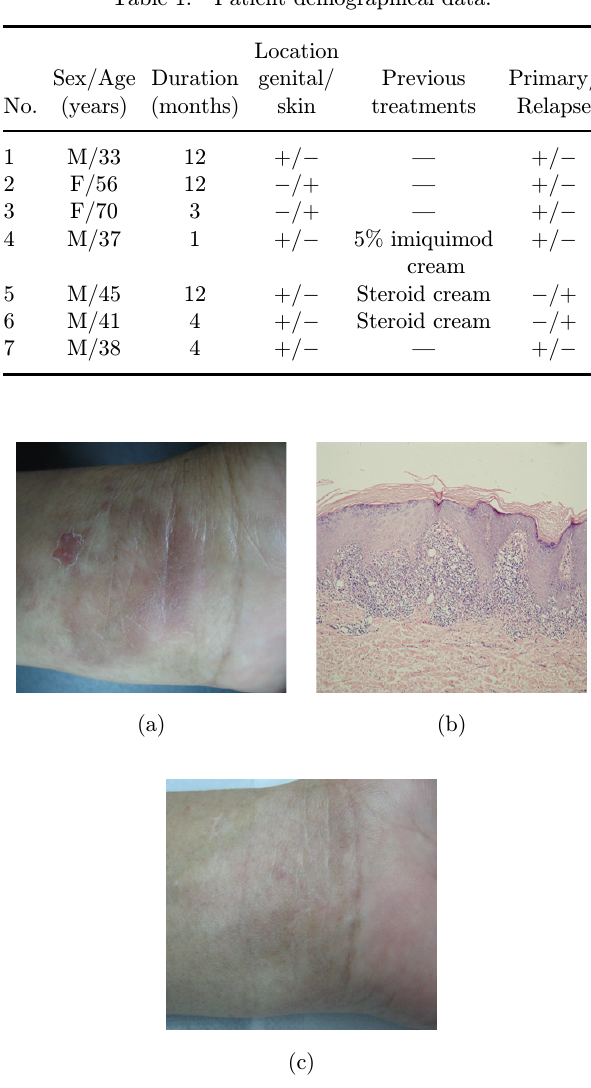
Table 1. Patient demographical